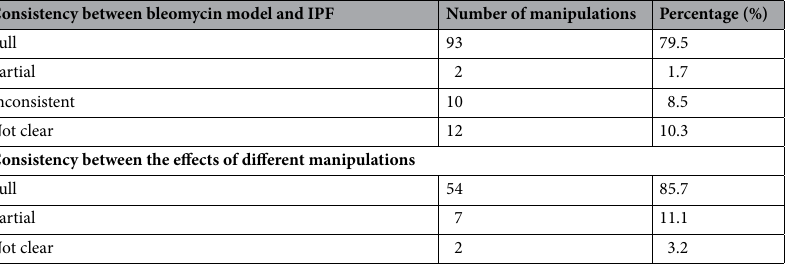
Table 2. Consistency between the effects of genetic/protein manipulations on bleomycin-induced lung fibrosis in mice and expression of corresponding genes in human IPF. For a detailed list see Supplementary Table ST1, ST2 and ST3.